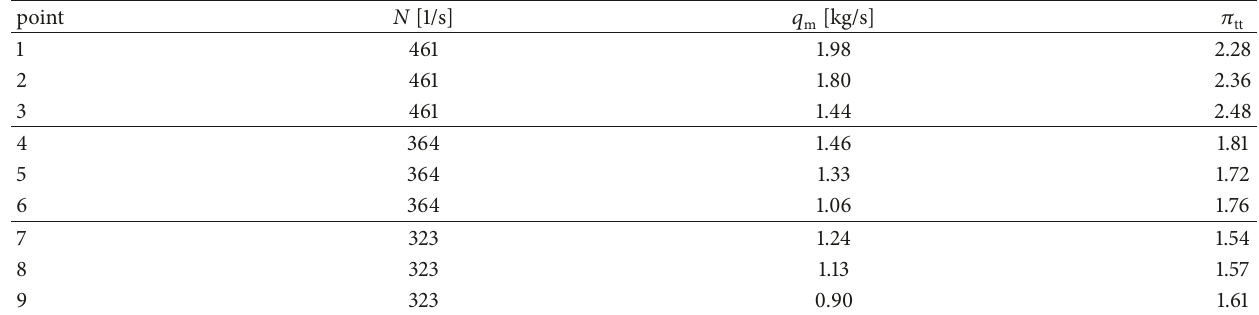
Table 4: Operating points at which the static pressures were